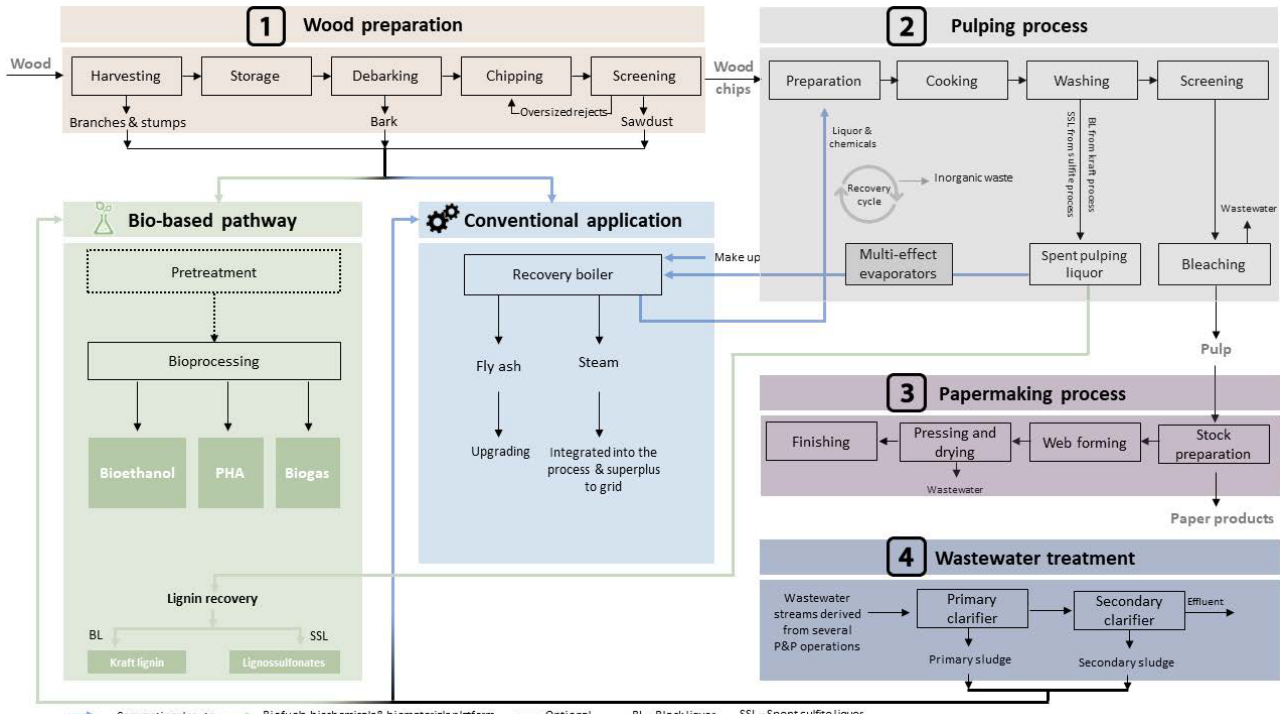
Figure 1. Simplified flowsheet of the wood preparation, pulping, papermaking process and wastewater treatment processes.